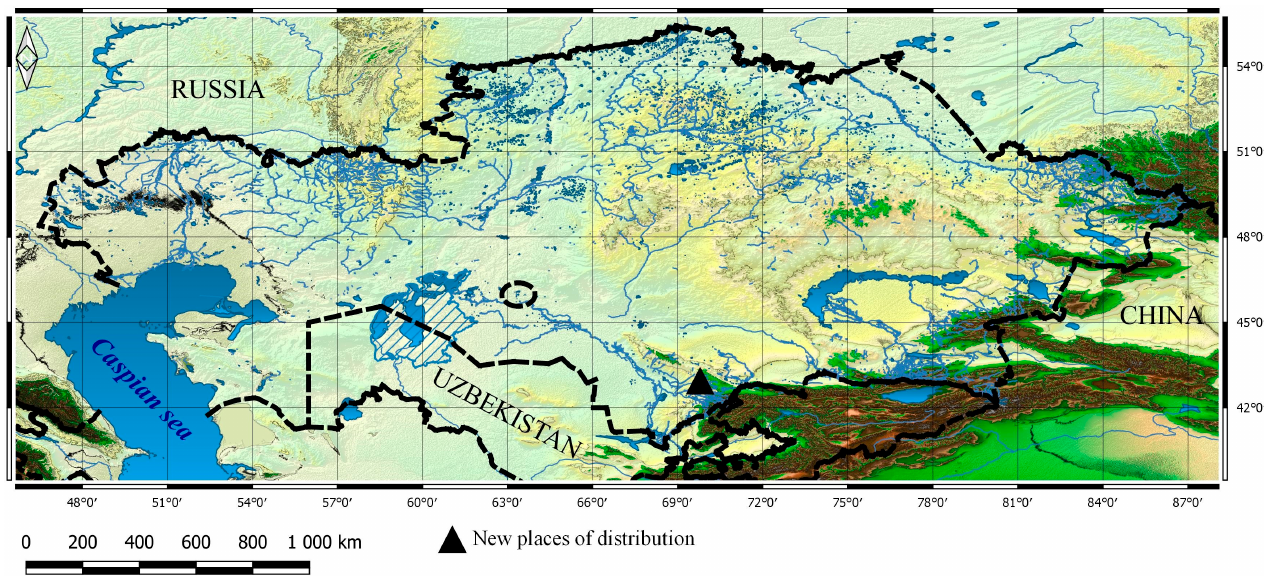
Figure 7. Distribution of Dactylorhiza magna (Czerniak.) Iconn. in Kazakhstan. 3.2.5. Dactylorhiza majalis subsp. baltica (Klinge) H.Sund., Europ. Medit. Orchid., ed. 3: Karatau: Berkara gorge, 15.VIII.1946, N.V. Pavlov (AA!). 40 (1980). ≡ Orchis latifolia subsp. baltica Klinge, Trudy Imp. S.-Peterburgsk. Bot. Sada